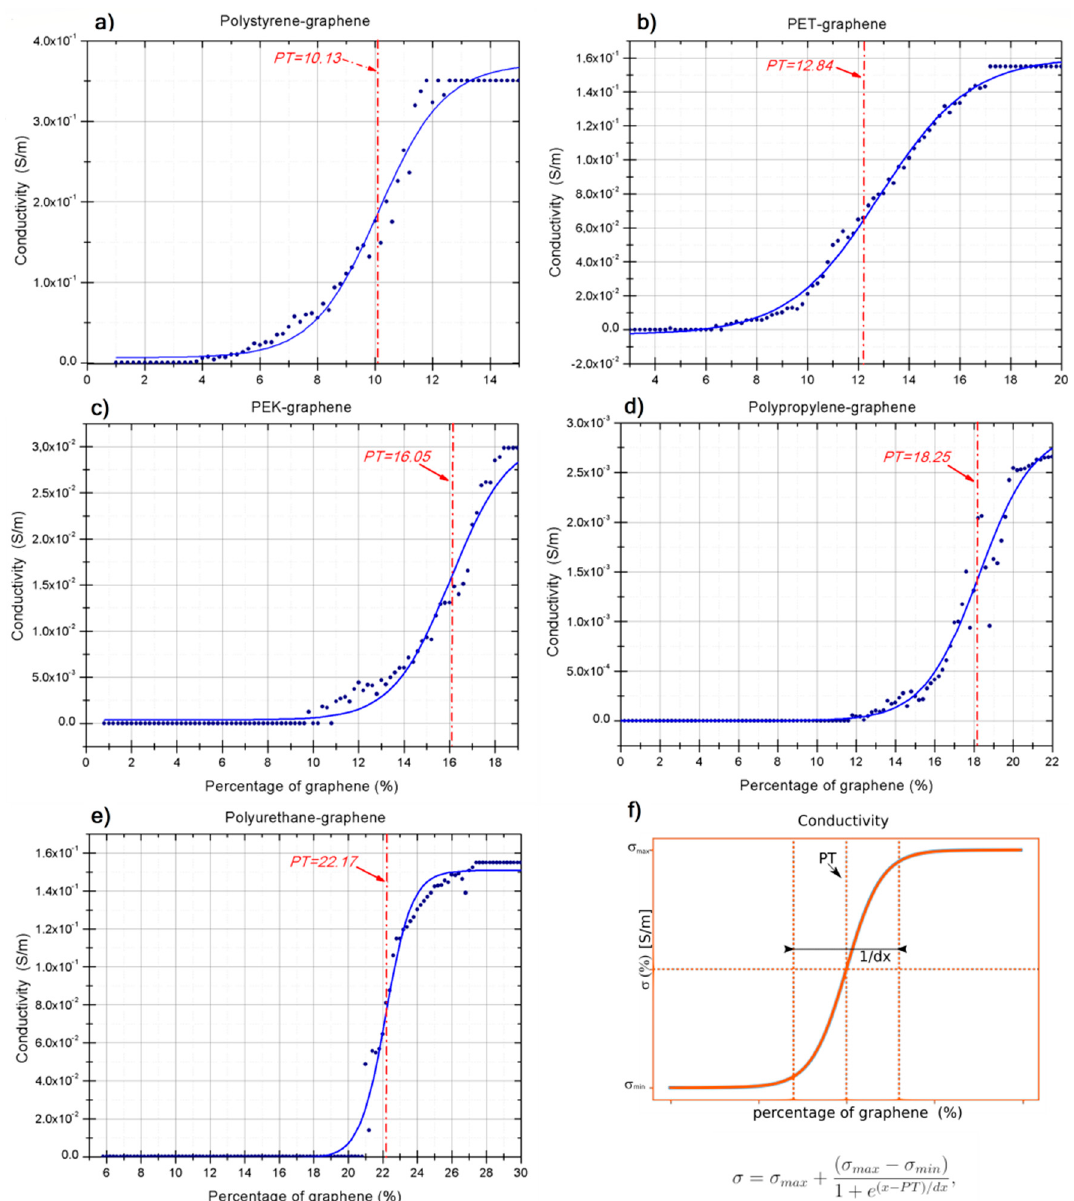
Figure 4. The electrical conductivity versus % of graphene nanoparticles incorporated in the polymer. The blue dots are the values obtained by the simulation, the blue curve is the interpolation made with the sigmoidal Boltzmann, and the vertical red line is the percolation threshold. ( a ) The nanocomposite formed by Polystyrene-graphene, ( b ) PET-graphene, ( c ) PEK-graphene, ( d ) Polypropylene-graphene, ( e ) Polyurethane-graphene. Subfigure ( f ) shows a generalized graphical representation of the sigmoidal Boltzmann to compare with the values obtained in the simulation. Table 4. Parameters used in the fitting of the conductivity values, obtained with Equation (3).